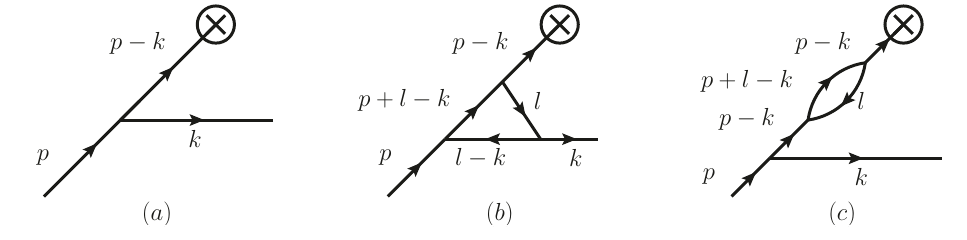
Figure 3 . Cut diagrams for the real-virtual contribution.